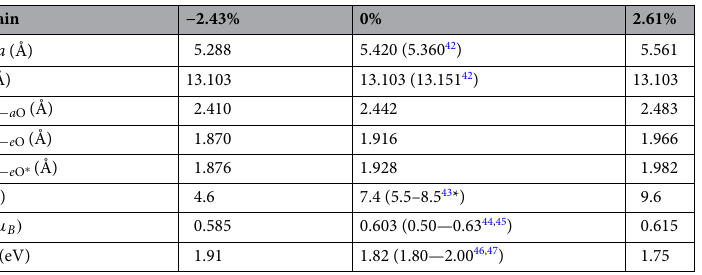
Table 1. Optimized structural parameters of La 2 CuO 4 in the LTT phase calculated under -2.43%, 0%, and 2.61% biaxial strains. Available experimental values were also listed in parenthesis with their corresponding references. Note that experimental references did not specify in what phases they measured their values. *Means the calculated value using various